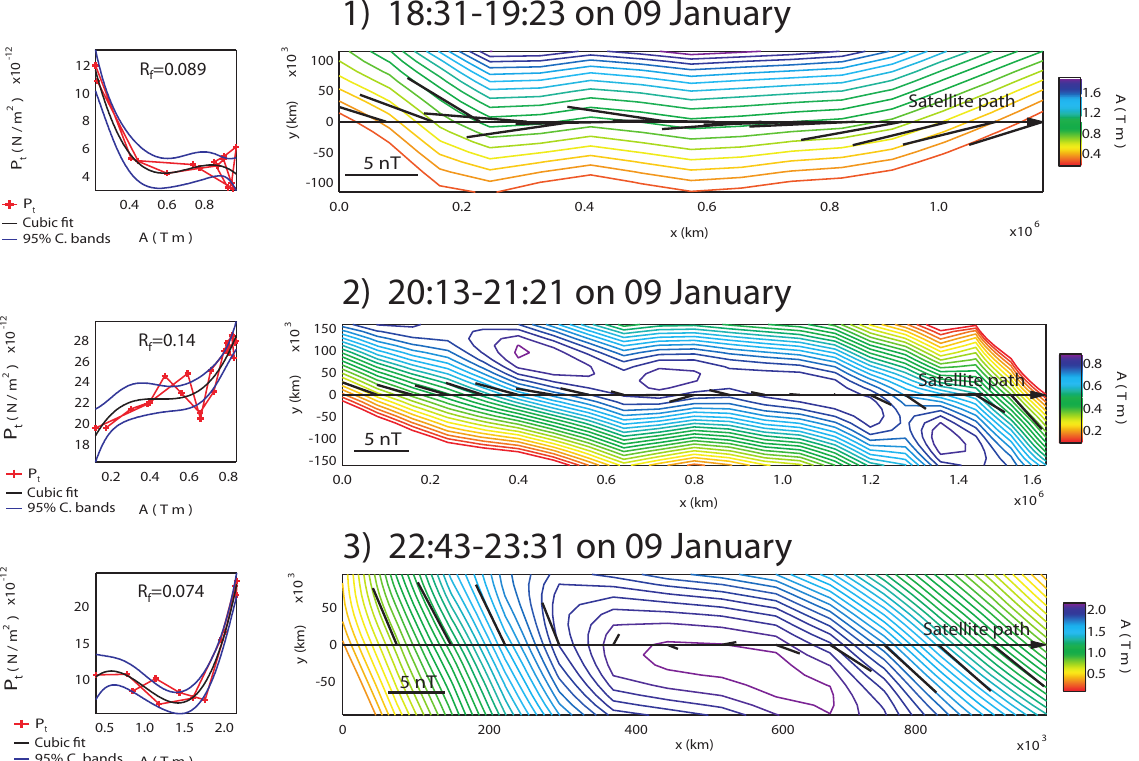
Fig. 2. The results of Grad–Shafranov reconstruction for the structures highlighted with blue-shaded areas in Fig. 1. The left panels illustrate the behaviour of P t (A) (red line), the black lines report the third-order polynomials fits of P t (A) used for the GS reconstruction and the blue lines represent the 95% confidence bands of the fit. The fitting residual R f is a quantitative estimation of the deviation from the model assumptions. In the right panels, the magnetic field maps obtained with the GS reconstructions are reported. The equipotential lines of A , reported with the colour scale, represent the magnetic field lines in the reconstruction plane. The horizontal lines at the centre of the maps show the satellite path through these structures, whose dimensions are reported along the axes in km. The black lines along the satellite path show the projection on the x - y plane of the magnetic field vectors measured by the spacecraft along it trajectory (a scale corresponding to 5nT is